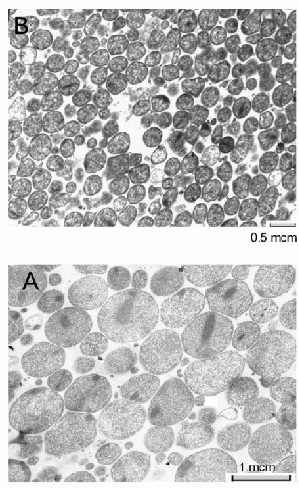
FIGURE 1. Electron micrography of A. laidlawii PG8 cells. Cultures were grown on Edward’s medium for 2 days (A) and on the impoverished medium for 480 days (B).